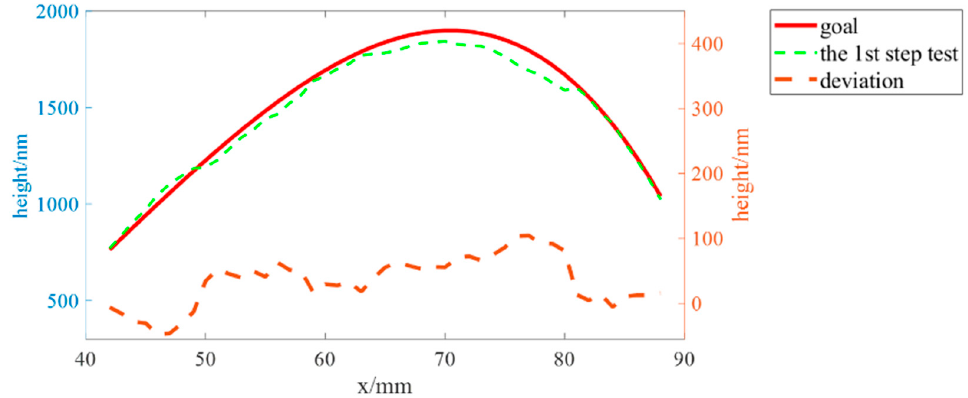
Figure 14. Comparison of film thickness distribution with ideal thickness distribution.